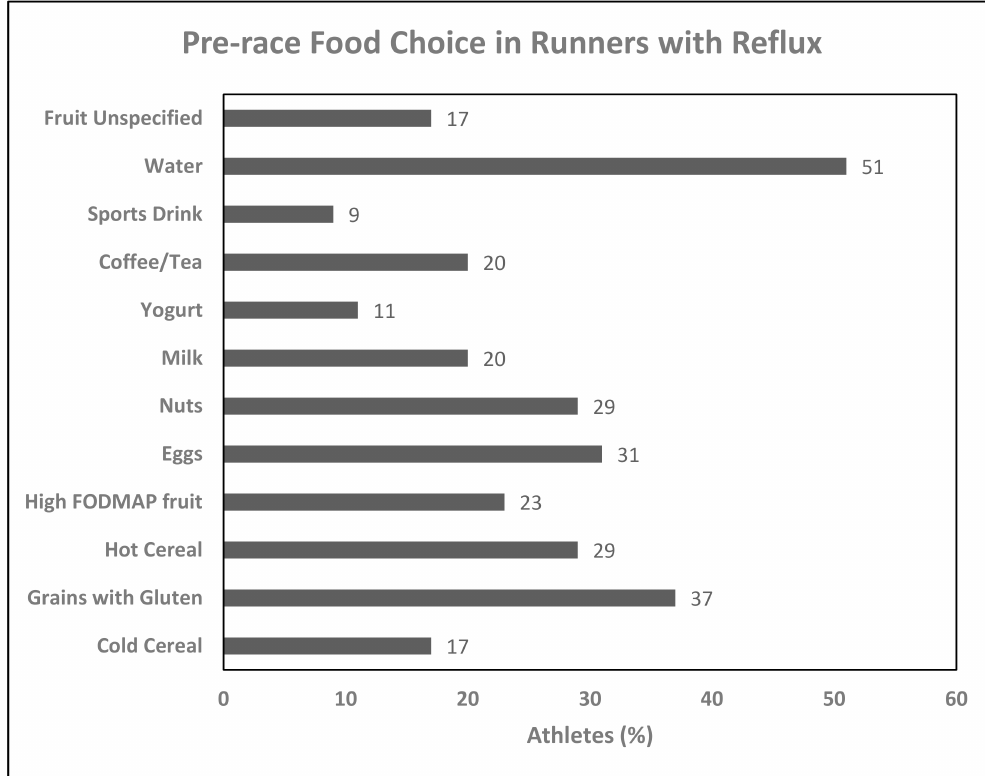
Figure 2. Commonly consumed foods pre-race for runners with